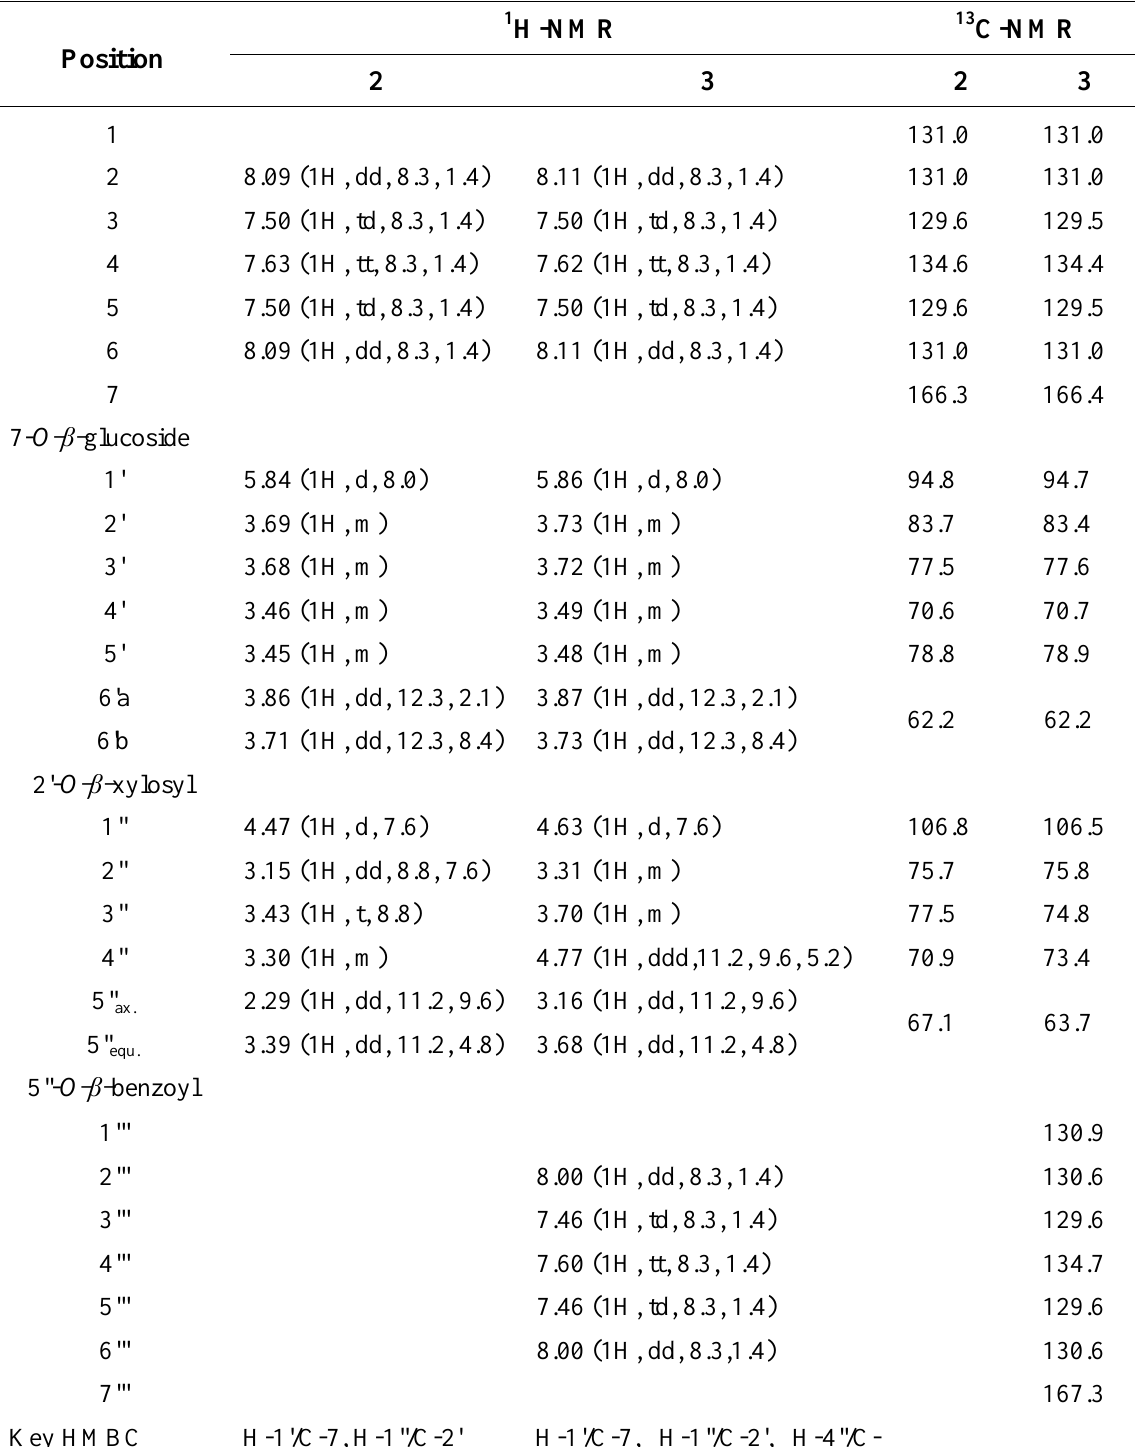
Table 1 . 1 H-NMR (400 MHz) and 13 C-NMR (100 MHz) spectral data a of compounds 2 OD ( δ in ppm, J in Hz) and 3 in CD 3